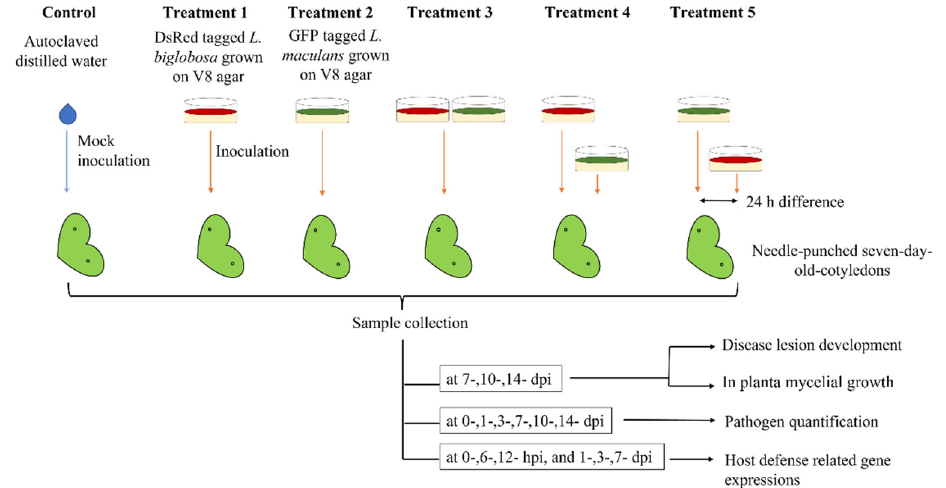
Figure 6. Schematic representation of the research design. Seven-day-old Westar cotyledons were wound inoculated with Control: distilled water treatment; Treatment 1: LbDsRed inoculation; Treatment 2: LmGFP inoculation; Treatment 3: LbDsRed and LmGFP co-inoculation; Treatment 4: LbDsRed followed by LmGFP inoculation (in 24-h intervals); Treatment 5: LmGFP followed by LbDsRed inoculation (in 24-h intervals). Inoculated cotyledons were collected at different time points to analyze the lesion development in planta mycelial development, pathogen quantification, and host-defense-related gene expressions.